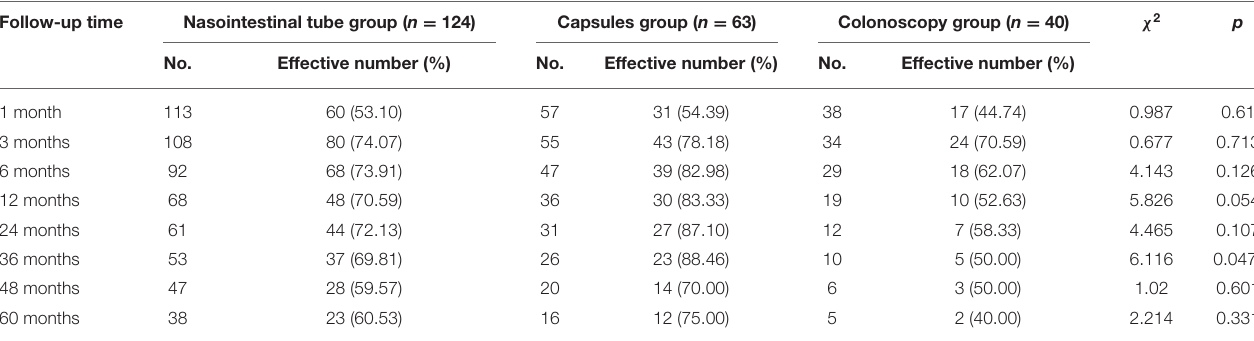
TABLE 2 | The effect of different transplantation routes on